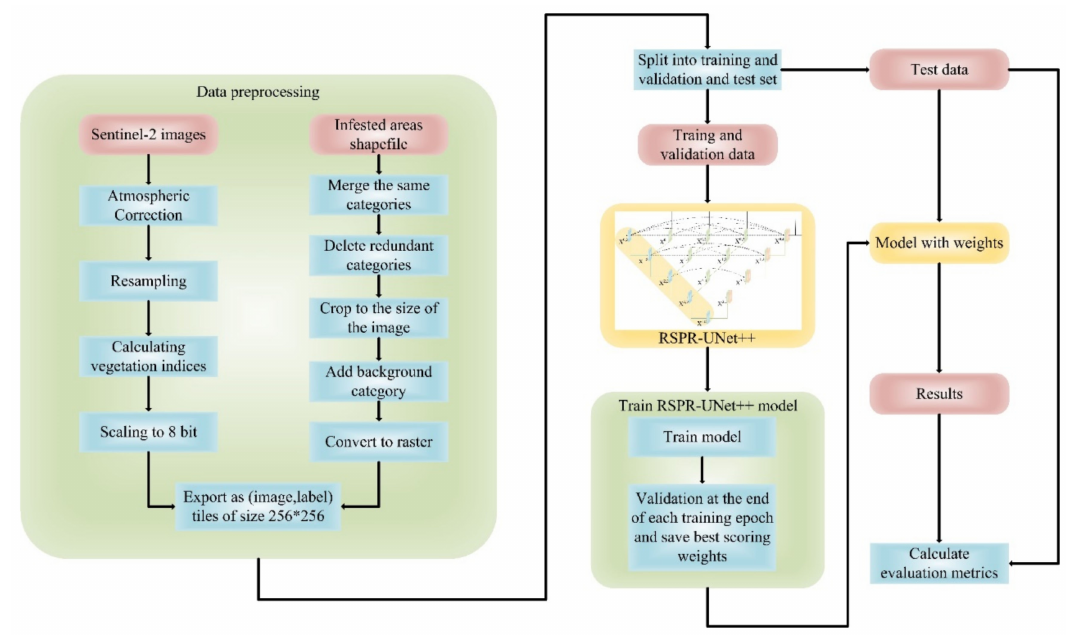
Figure 6. A flow chart of the process of creating the dataset together with the process of training, validating, and testing the